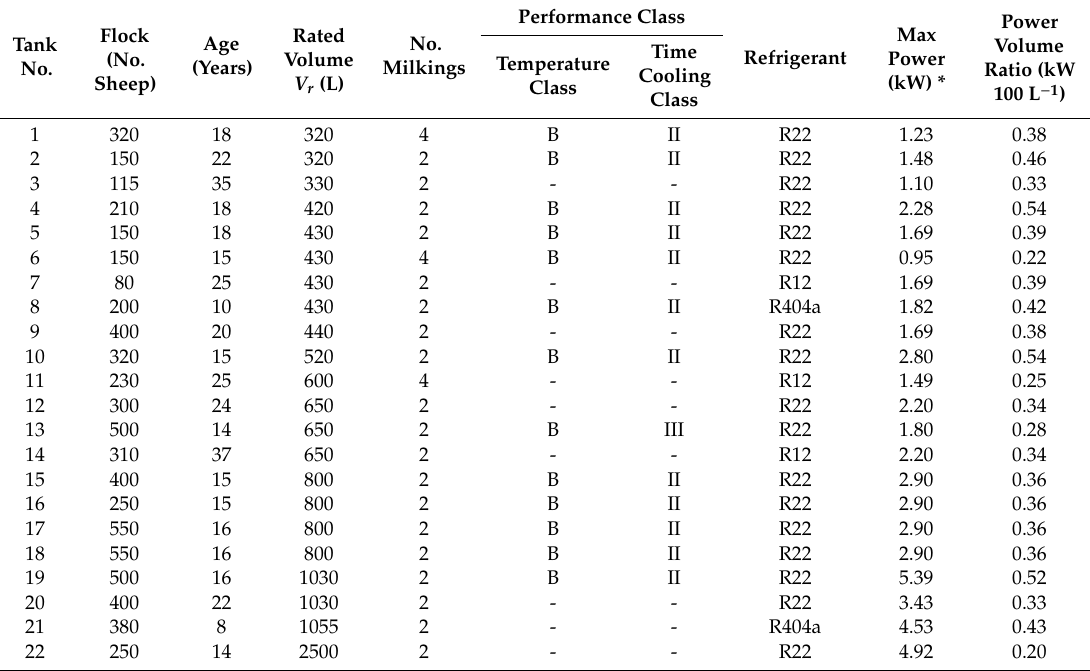
Table 2. Technical specifications of the MCSs of the sample. The systems are listed from the lowest rated volume. Tank